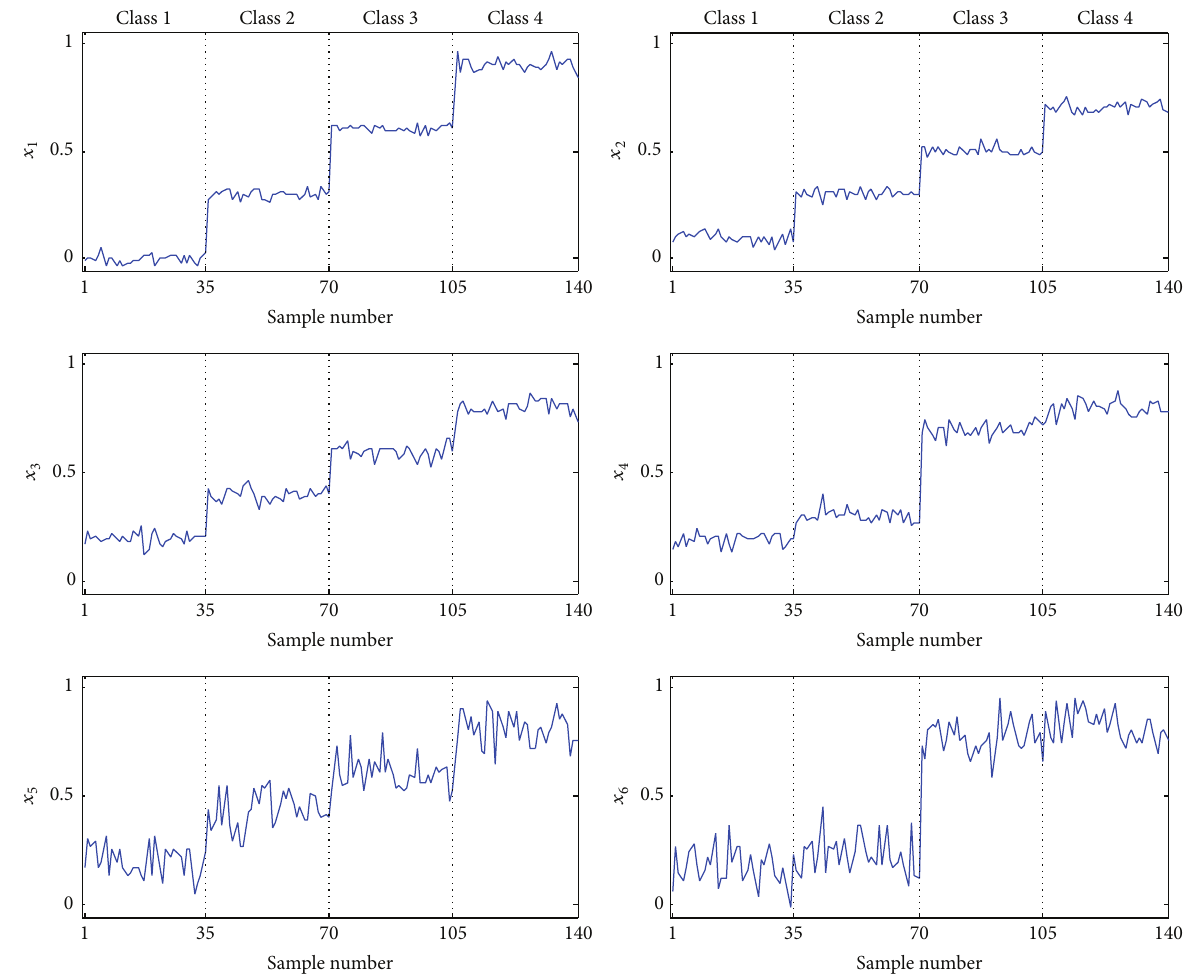
Figure 9: The distribution of six features under four classes, where 𝑥 𝑖 (𝑖 = 1, 2, . . . , 6) represent features.